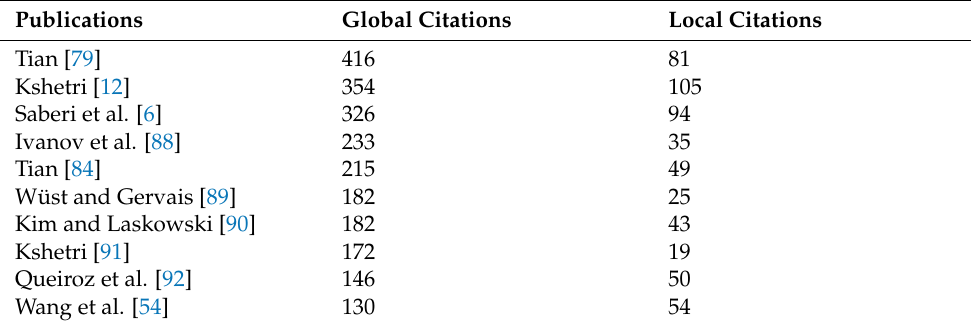
Table 7. Top ten papers according to global